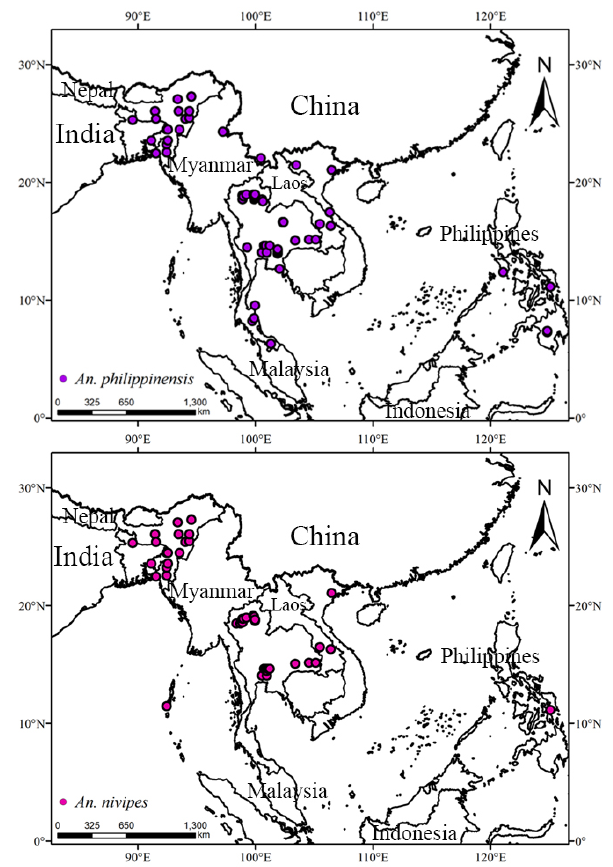
Figure 1. Global distribution of Anopheles philippinensis and Anopheles nivipes